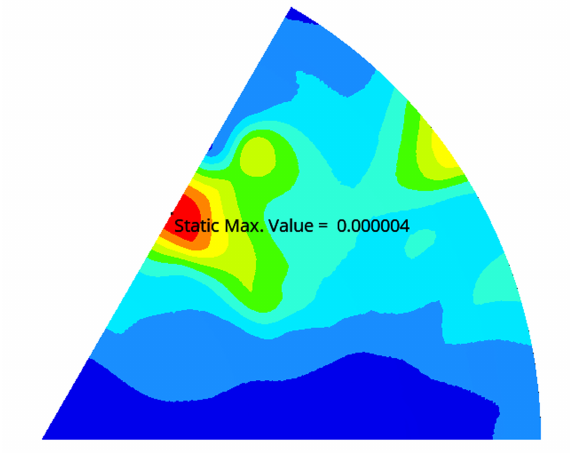
Figure 8. The mirror deformation under